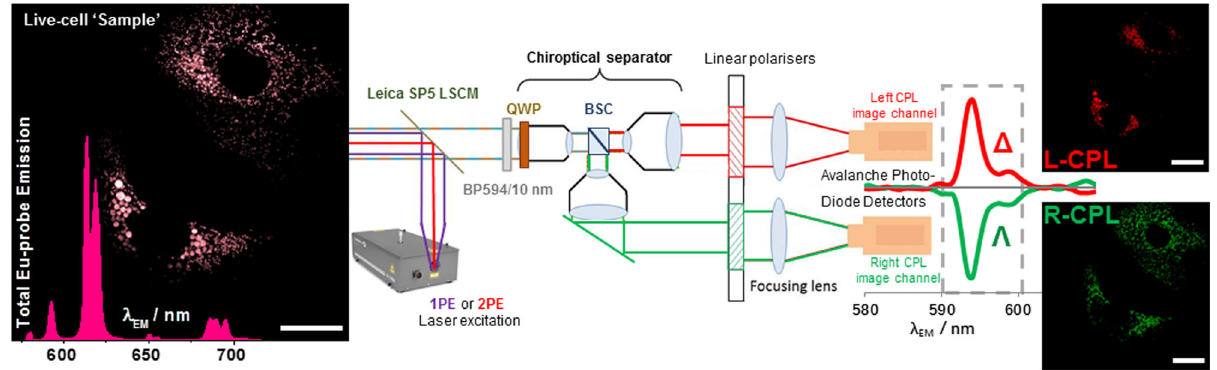
Fig. 2 Simpli fi ed depiction of the CPL-LSCM developed for enantioselective differential chiral contrast (EDCC) imaging. The external CPL-LCSM module is attached to a commercial LSCM via a dedicated external (X1) port to facilitate simultaneous parallel diffraction-limited enantioselective imaging of CPL-active probes within live cells. Scale bars = 20 µ